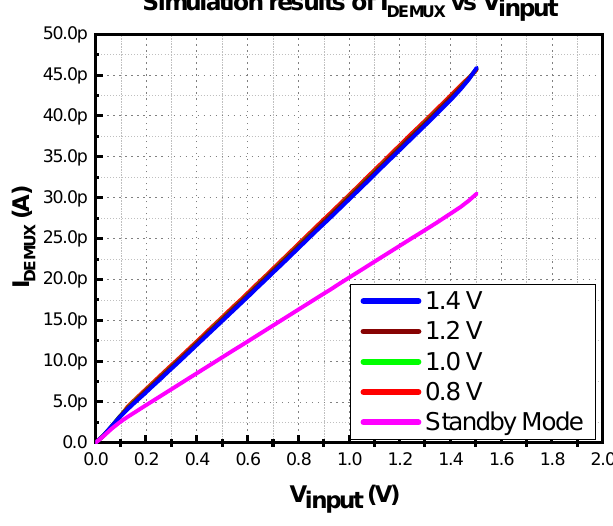
Figure 5. Simulation results of MVD-DEMUX’s current